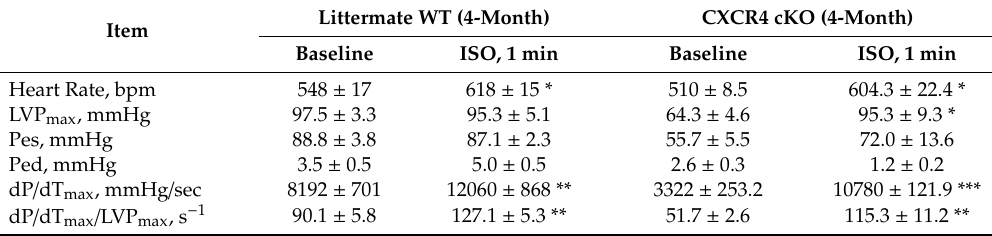
Table 2. In vivo hemodynamics: Pressure-volume data were analyzed using IOX2 software. The PV catheter was inserted into the left ventricle via an open-chest, transapical stab and cardiac hemodynamic data was acquired. For this experiment we used mice at 4 months of age. Prior to infusion of isoproterenol, we observed significant di ff erences in baseline hemodynamics between CXCR4 cardiac deficient mice and wild-type controls. The CXCR4 cKO exhibited lower systolic pressures, ejection fraction, and dp / dt max as compared to controls. Our data demonstrated that CXCR4 deficient mice had an augmented response to ISO with a greater increase in ejection fraction (EF) and dp / dt max . Abbreviations: LVP, left ventricular pressure; CO, cardiac output; SV, stroke volume; EF, ejection